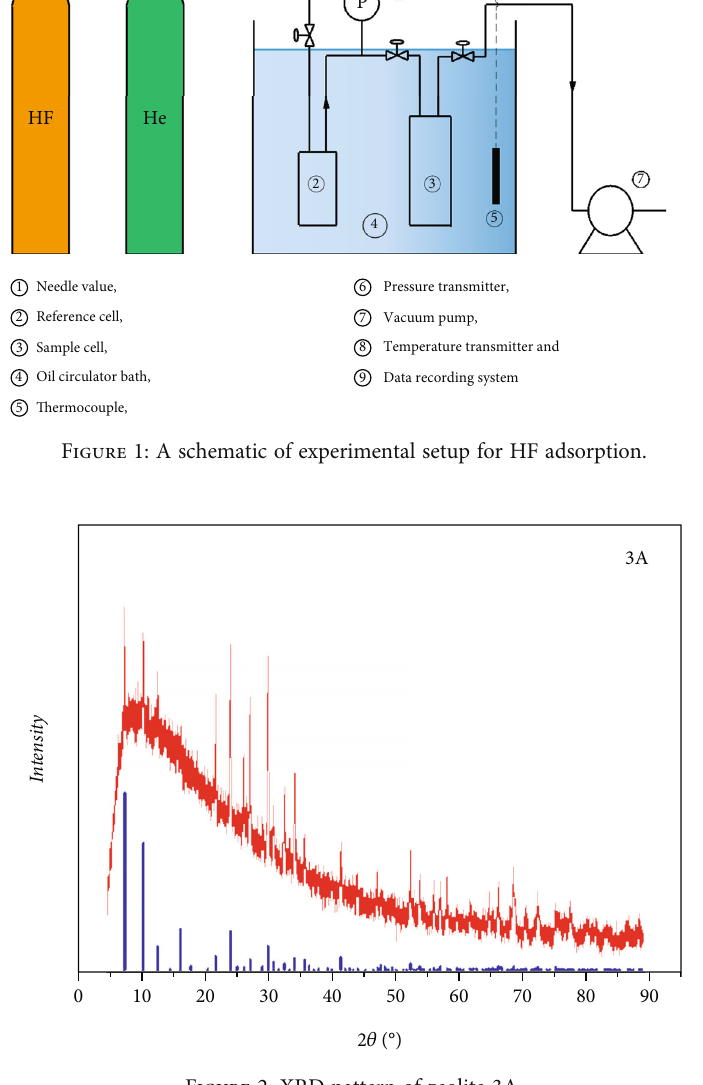
Figure 2: XRD pattern of zeolite